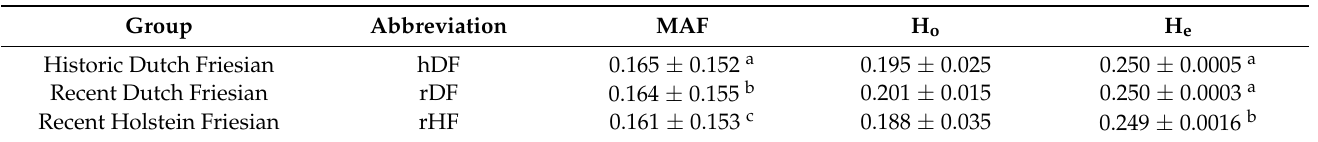
Table 1. Genetic diversity parameters of within-group diversity of hDF, rDF, and rHF (mean ± standard deviation).